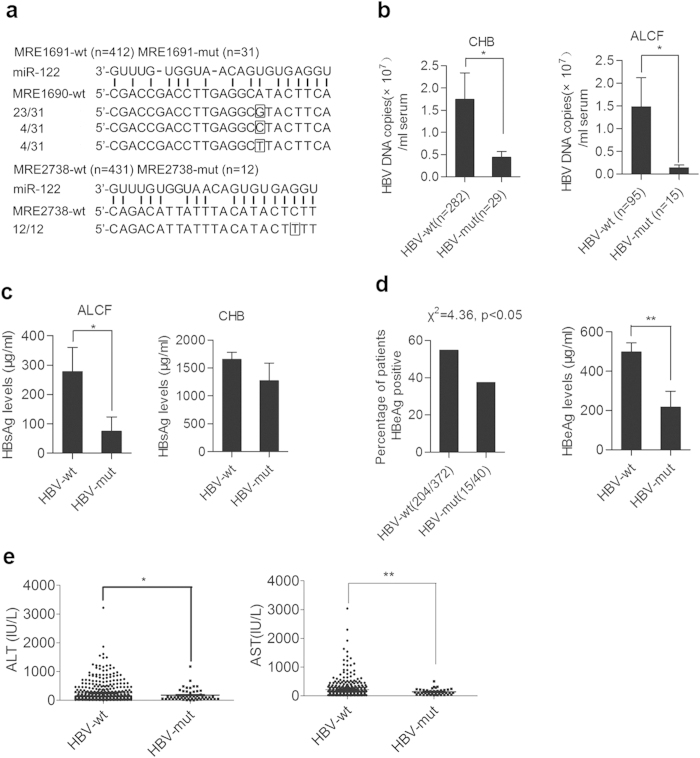
Mutations in viral miR-122 response elements are correlated with viral DNA loads and disease progression in HBV-infected patients.(a) The frames indicate mutations in the miR-122 response elements in the HBV genome of virus isolates from HBV-infected patients. The number of patients infected with HBV containing wild type or mutant miR-122 response elements and the mutation frequency in patients are shown. (b–e) Distribution of serum HBV DNA loads (b), HBsAg levels (c) HBeAg status (d) and ALT and AST levels (e) in in CHB and ALCF patients infected with HBV containing wild type or mutant miR-122 response elements. Pearson’s χ2 test was used to determine P values. *, P < 0.05; **, P < 0.01.